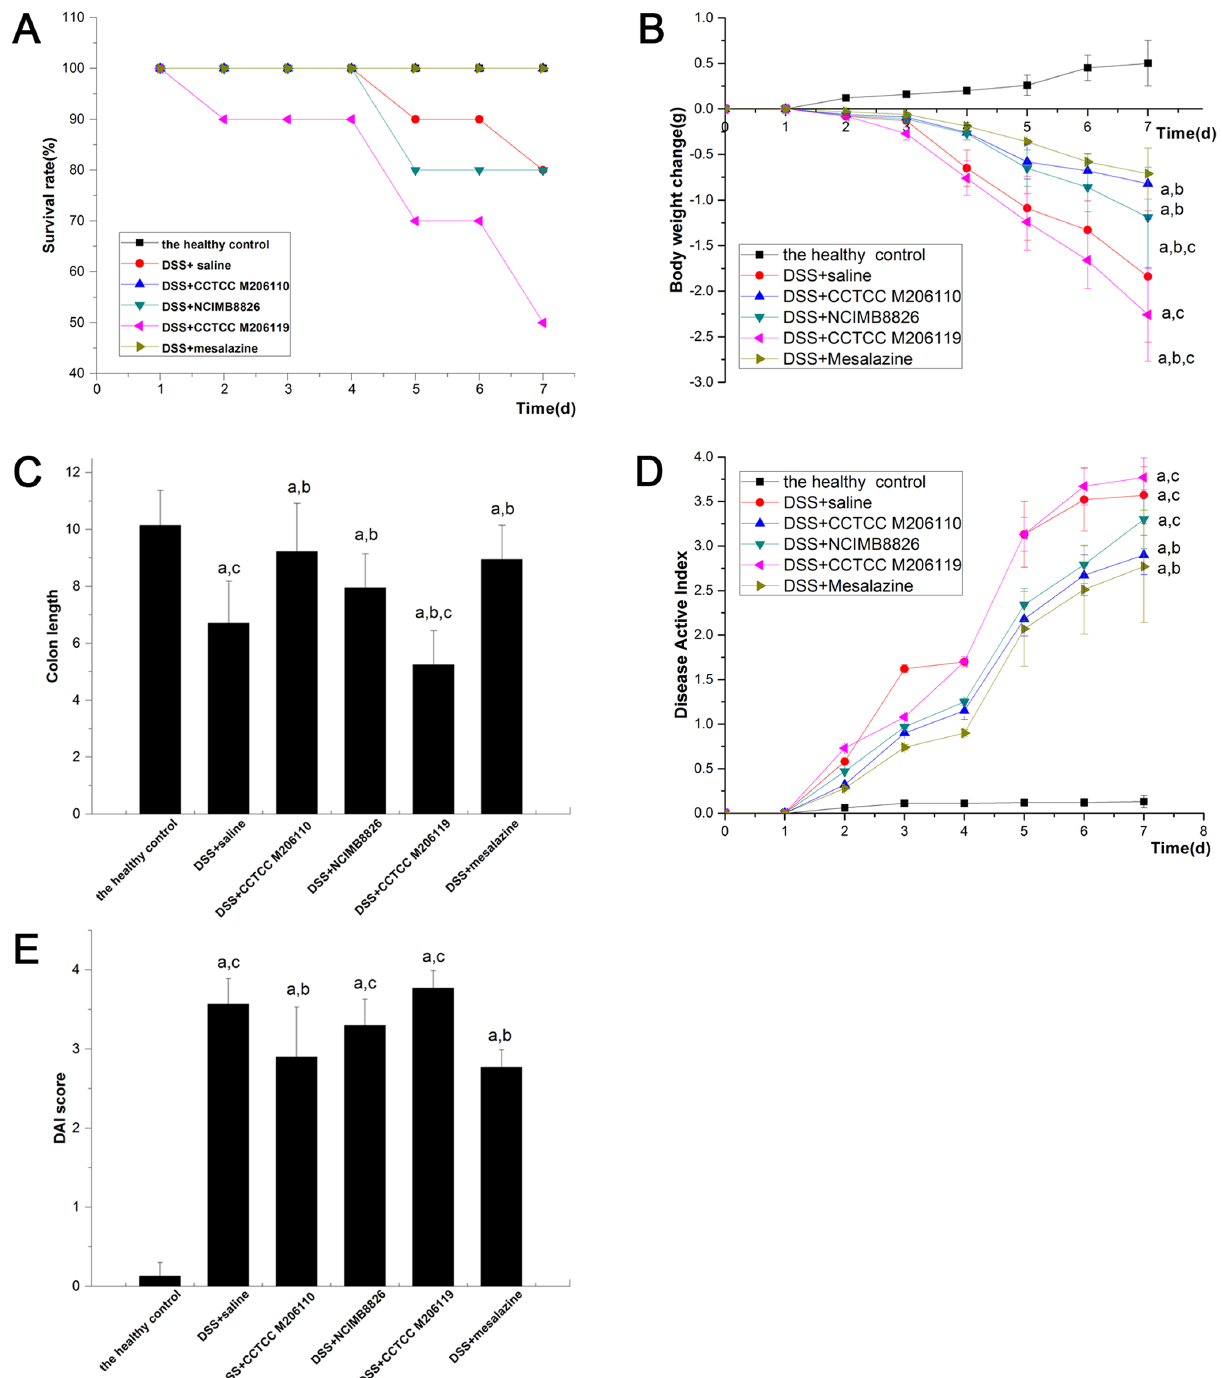
Fig 2. Effects of Lactobacillus strains NCIMB8826, CCTCC M206119, and CCTCC M206110 in dextran sulfate sodium-colitis mice. (A) Survival rate of six BALB/c mouse groups ( n = 10) by the end of the experiment. (B) Effects of Lactobacillus strains treatments on colitis-induced body weight loss. The x- axis shows the mean weight (mean ± SD) recorded for each group on each day of the 7-day colitis induction. (C) Effects of Lactobacillus strain treatments on colitis-induced changes in colonic length. (D) Effects of Lactobacillus strains on colitis-induced changes in DAI scores. The daily mean DAI score ± SD is plotted for each group; E: Mean ± SD DAI scores on day 9. a P < 0.05 vs. the healthy control group; b P < 0.05 vs. the negative (saline) control group; c P < 0.05 vs. the positive (mesalazine) control group.